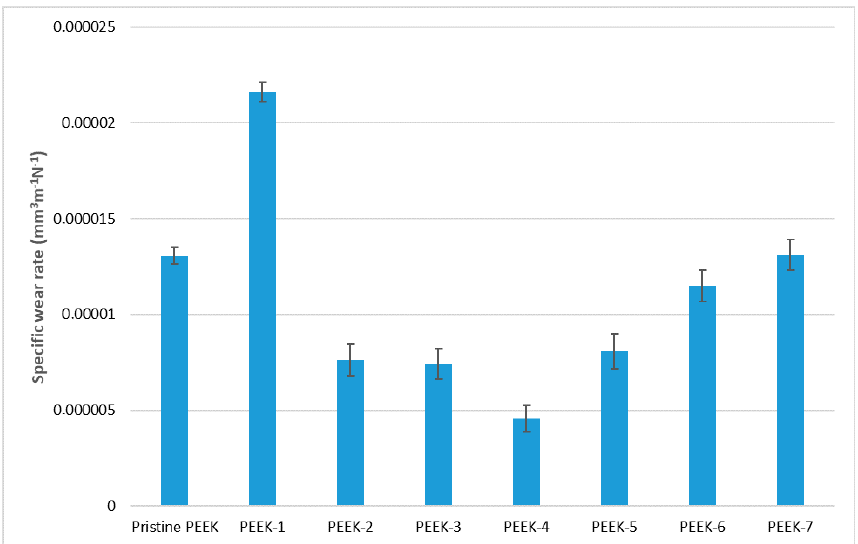
Figure 3. Variations of PEEK specific wear rate.